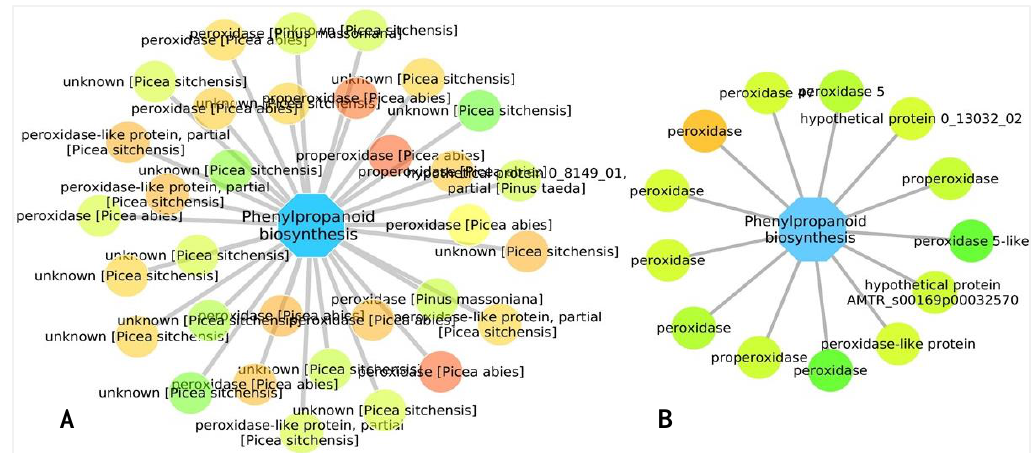
A B Figure 8. Phenylpropanoid biosynthesis pathway with interactions assigned to DEG in Pinus pinaster ( A ) and in Pinus yunnanensis ( B ) at the second time point after inoculation (48 h). The blue node represents the pathway. The circular nodes represent DEG assigned to the pathway. Note that due to the complexity of representing the expression values of those genes in all the stages, the expression was colored on an RGB scale that goes from the most down-regulated in red to the most up-regulated in green.